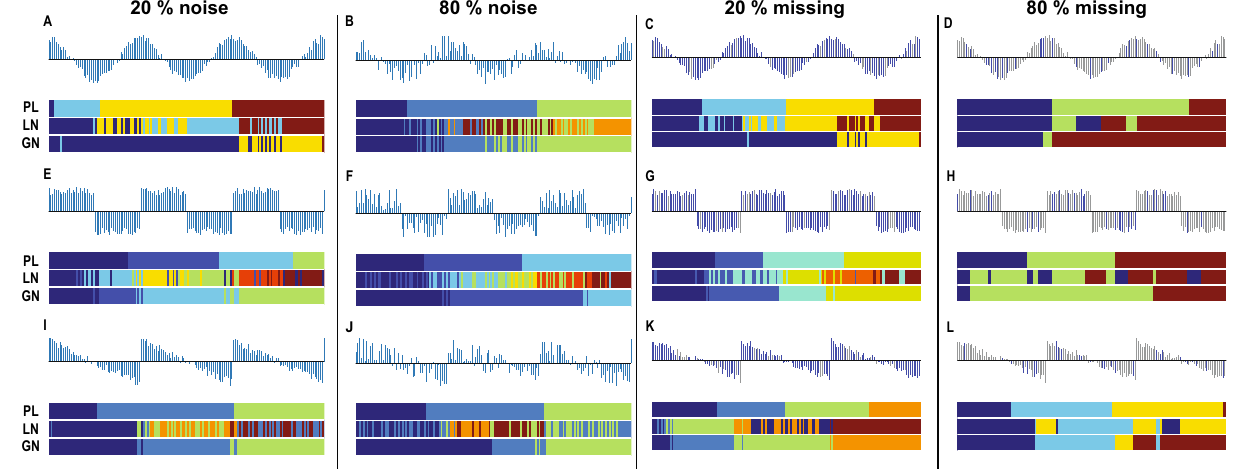
Figure 3. Community structure of different simulated signal time series. We simulated 3 types of signals: cosine time series ( A–D ), square wave time series ( E–H ) and saw-tooth wave time series ( I–L ). The community structure is represented by color bar, with time points in the same community assigned the same color. For each kind of signal, we also added 20% and 80% noise (the first and second subplots of each row respectively) to test the tolerance to noise. We also randomly removed 20% and 80% time points (the third and fourth subplots of each row respectively, where grey bars in the signal plots represent the removed time points, in the case of having 20% noise in the data) to check the robustness to missing data and uneven sampling. We compared our method (PL, first color bar of each subplot) with the two traditional community detection methods, Louvain method (LN, second color bar) and Girvan–Newman method (GN, third color bar). Our method identifies community structures matching with the characteristics of the various time series, even in the presence of noise or missing